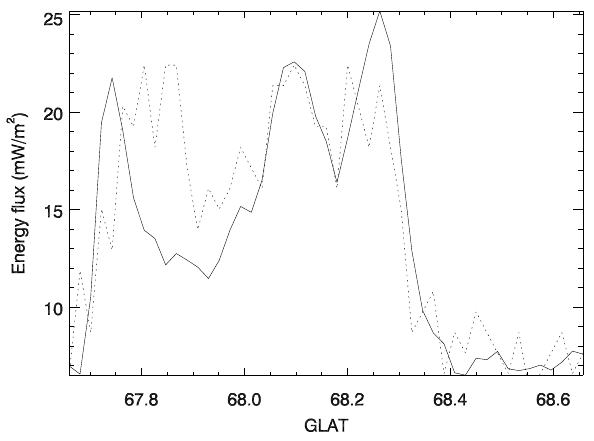
Fig. 7. A comparison of energy fluxes from blue ASC image along the DMSP satellite trajectory (dotted line) and blue line photometer data along the photometer scan (solid line) of the arc system on 31 January 2001 at 17:08:00UT. Conversion from the intensity (R) to the energy flux (mW/m 2 ) is done by Eq. (8) and the yield of blue photons of 200R/(mW/m 2